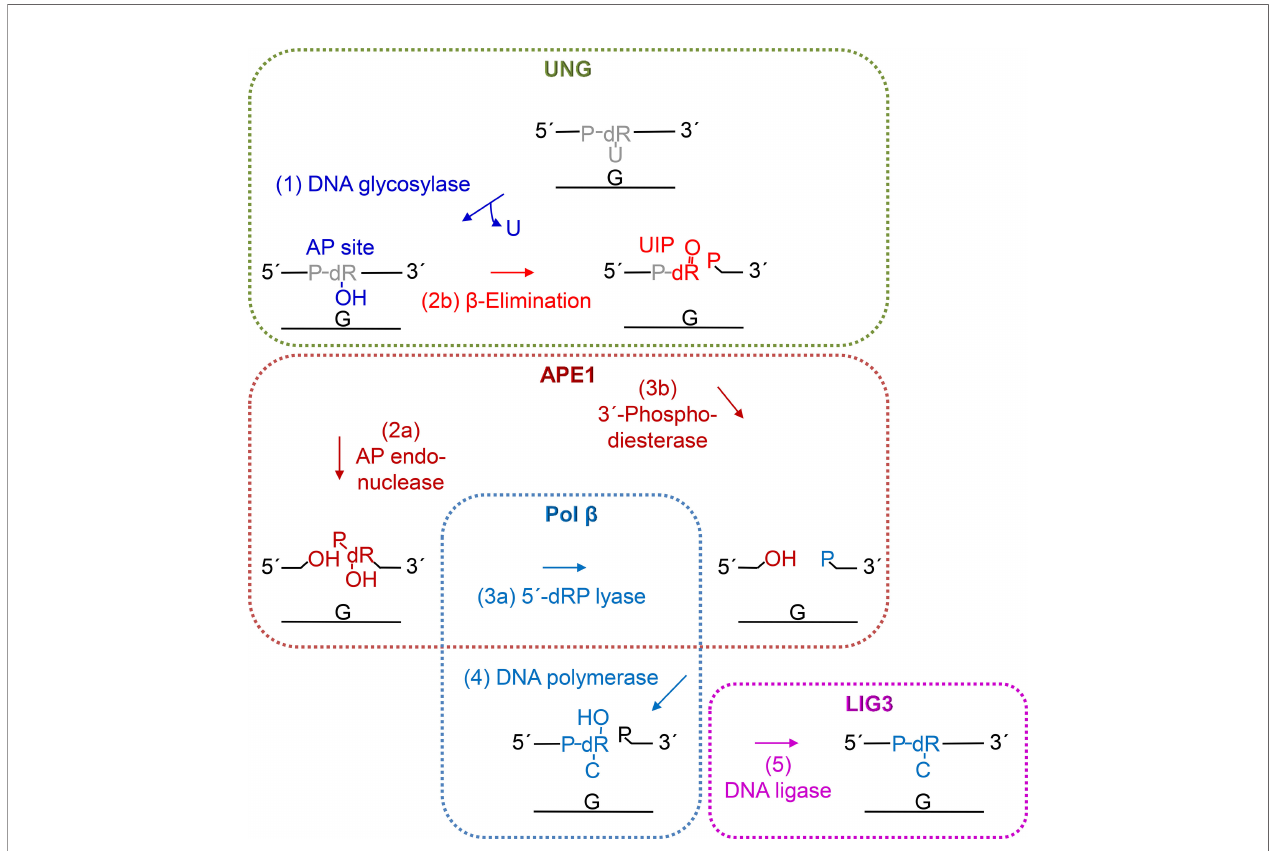
FIGURE 5 | Proposed steps of hUNG-initiated uracil BER. After uracil is removed (step 1, blue) by the DNA glycosylase activity of UNG (green), the AP site is mostly incised (step 2a) by APE1 (dark red) leaving behind a 3´-OH group. Then, the 5´-deoxyribose (dR) phosphate (P) remnant is removed by the dRP lyase activity (step 3a) of DNA polymerase b (Pol b , light blue), following conclusion of BER by insertion of the correct dCMP (step 4) by Pol b and nick-sealing (step 5) by DNA ligase III (LIG3, purple). Alternatively, UNG may itself incise the AP site (step 2b, red) by b -elimination ( Figure 2 , upper middle and right panels) leaving behind a 3´- a , b -unsaturated aldehyde (UIP; Figure 2 , middle right panel), which can be removed by the 3´-phosphodiesterase activity (step 3b) of APE1, and a 5´-P ( Figure 2 , lower right